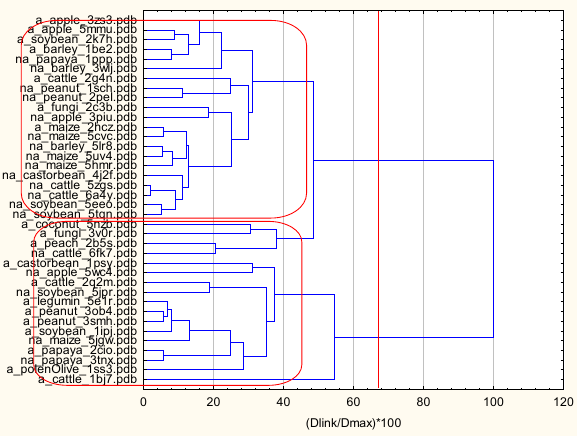
Figure 3: Hierarchical dendrogram for separation between allergenic (a) from non-allergenic (na)